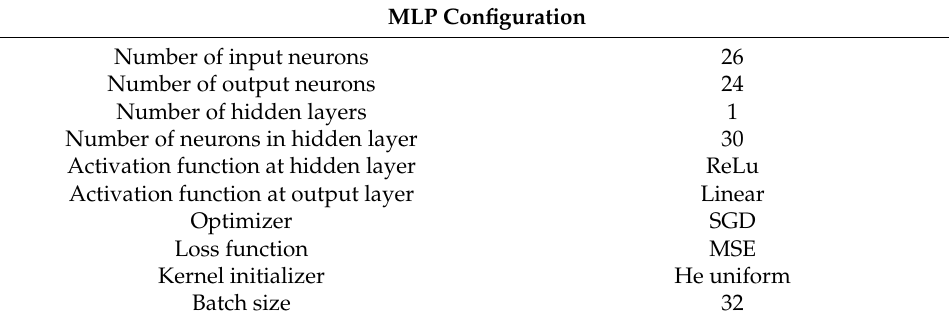
Table 3. MLP configuration used for local energy prediction models.